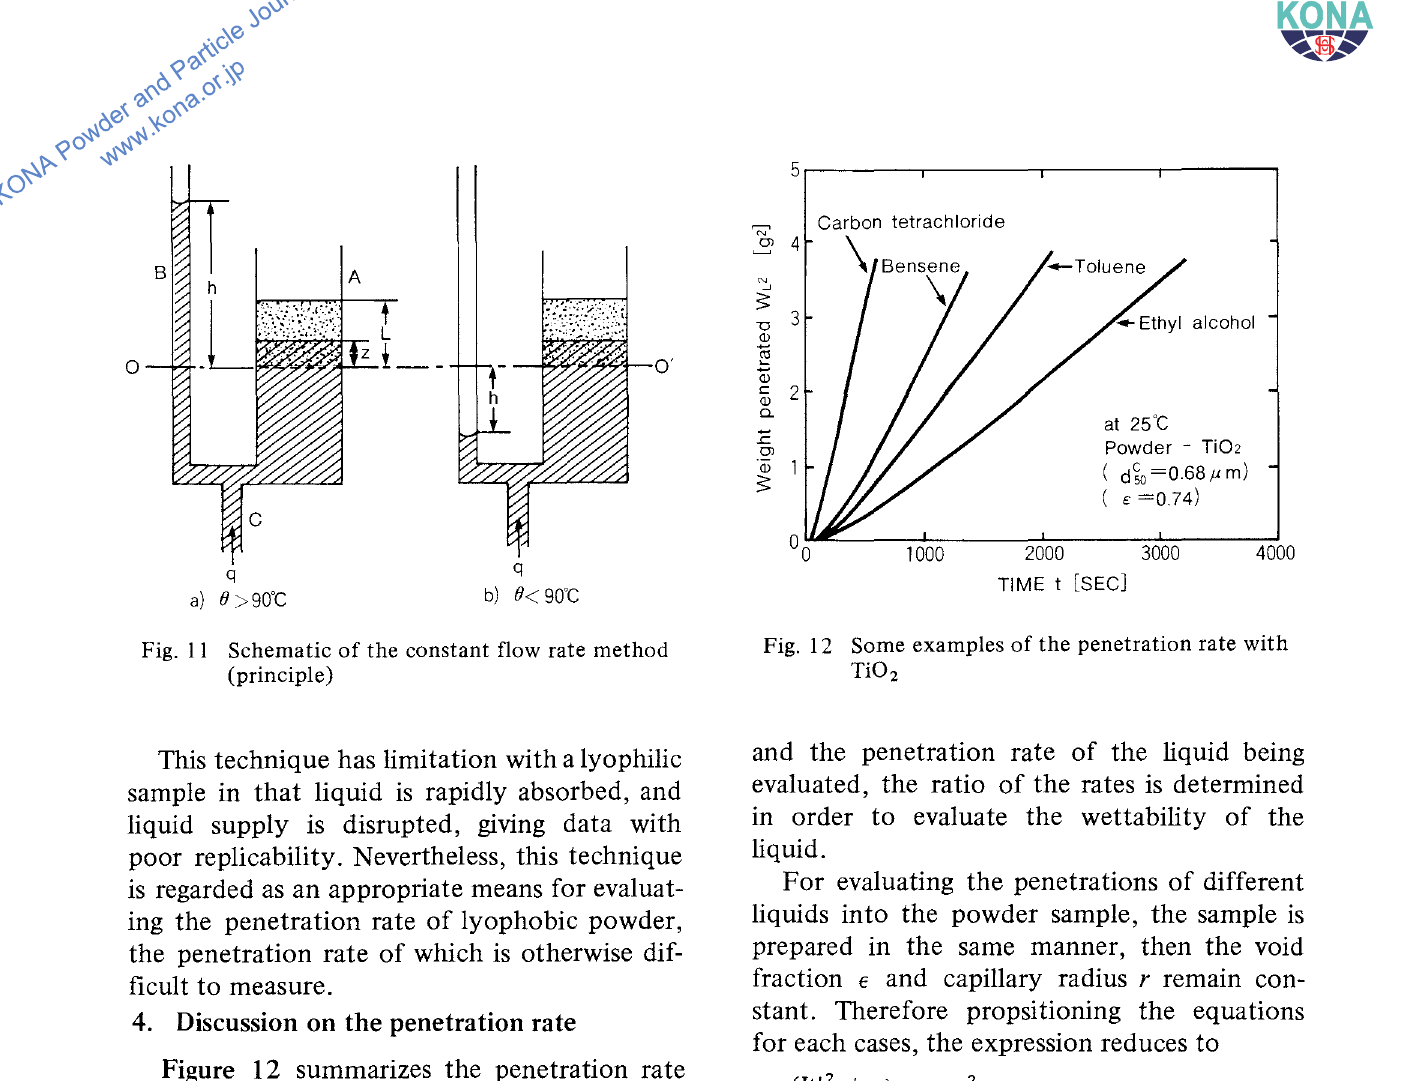
Fig. II Schematic of the constant flow rate method (principle)